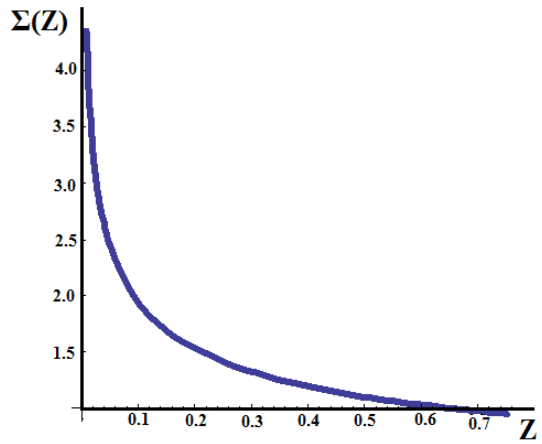
Figure 17. The distribution of the stress Σ ( Z ) in the right Λ -space. Hence, the stress Σ ( Z ) function corresponding to the axial stress applied in the Λ -space is transferred as the real stress, Σ ( z ), distributed along the bar in the initial space, and is defined through the relation: